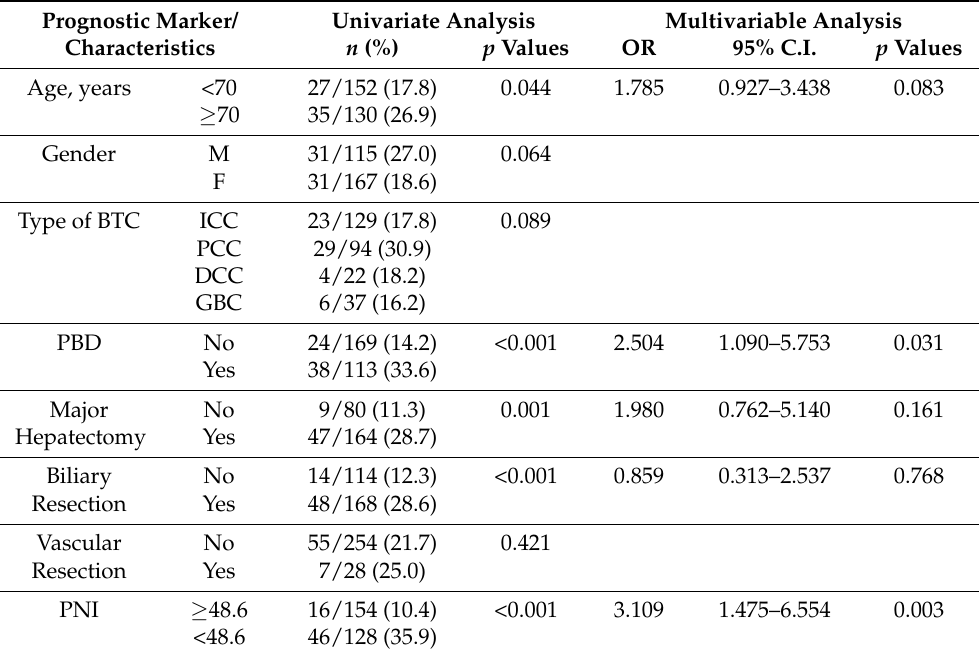
Table 7. Univariable and multivariable analysis for severe